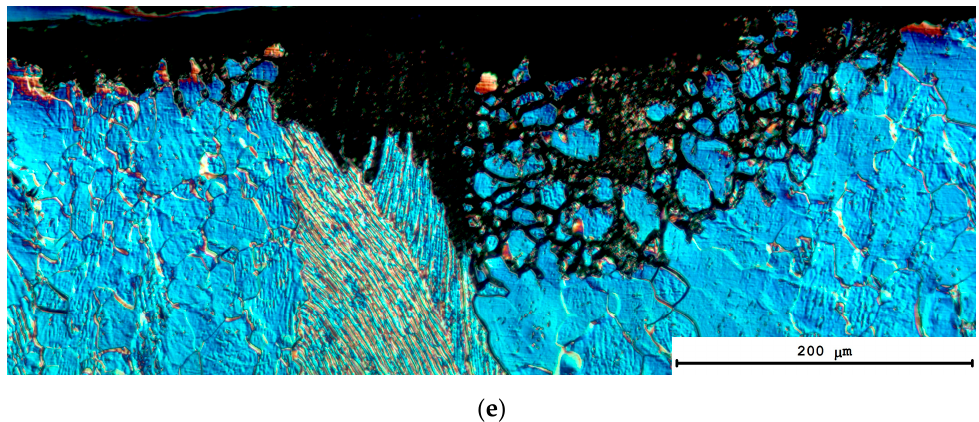
Figure 12. Corrosion defects on the surfaces of the coarse-grained specimens after HSC testing: ( a , b ) crevice corrosion in Zone I; ( c , d ) pitting corrosion in Zone II, ( e ) IGC in Zone II. Zones I and II are denoted in accordance with Figure 1c. Metallography.